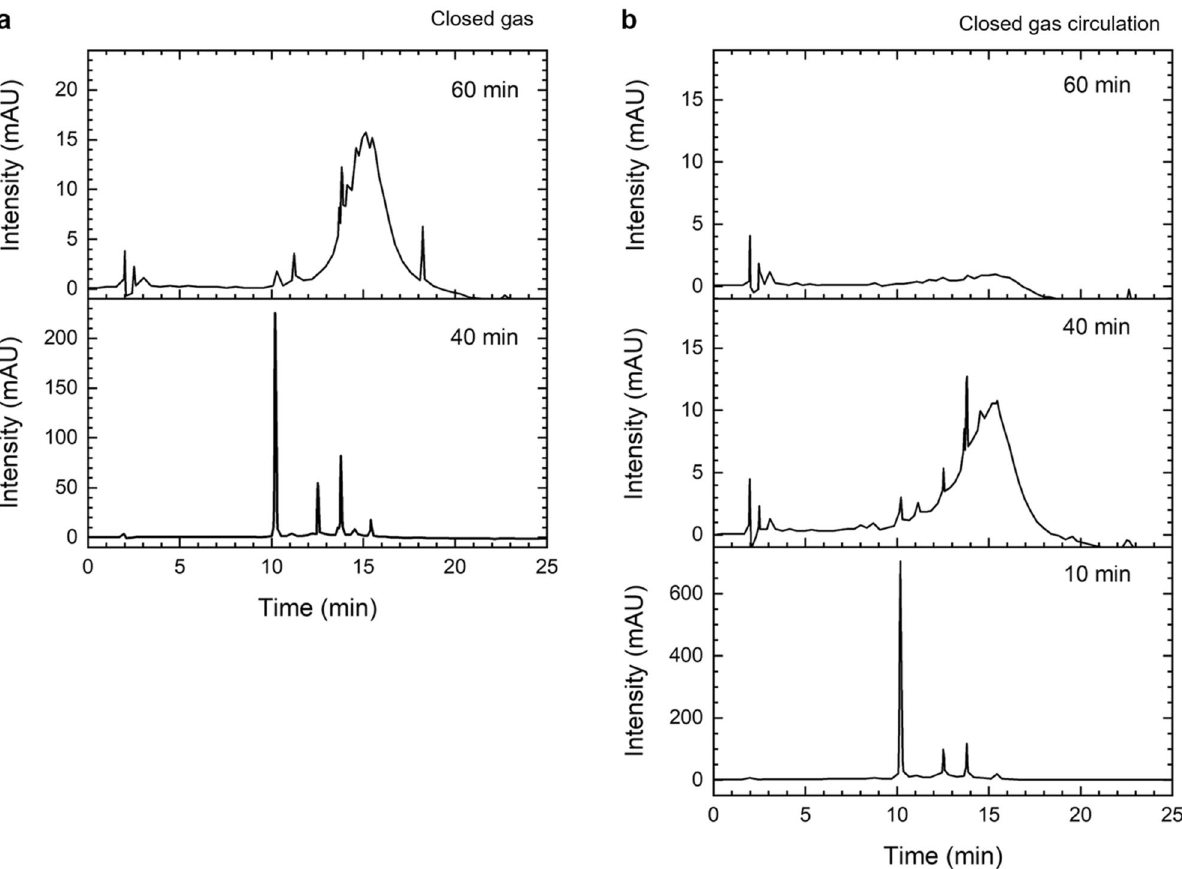
Figure 4. HPLC chromatograms of samples after plasma treatment for 60, 40, and 10 min: ( a ) Closed gas, and ( b ) Closed gas